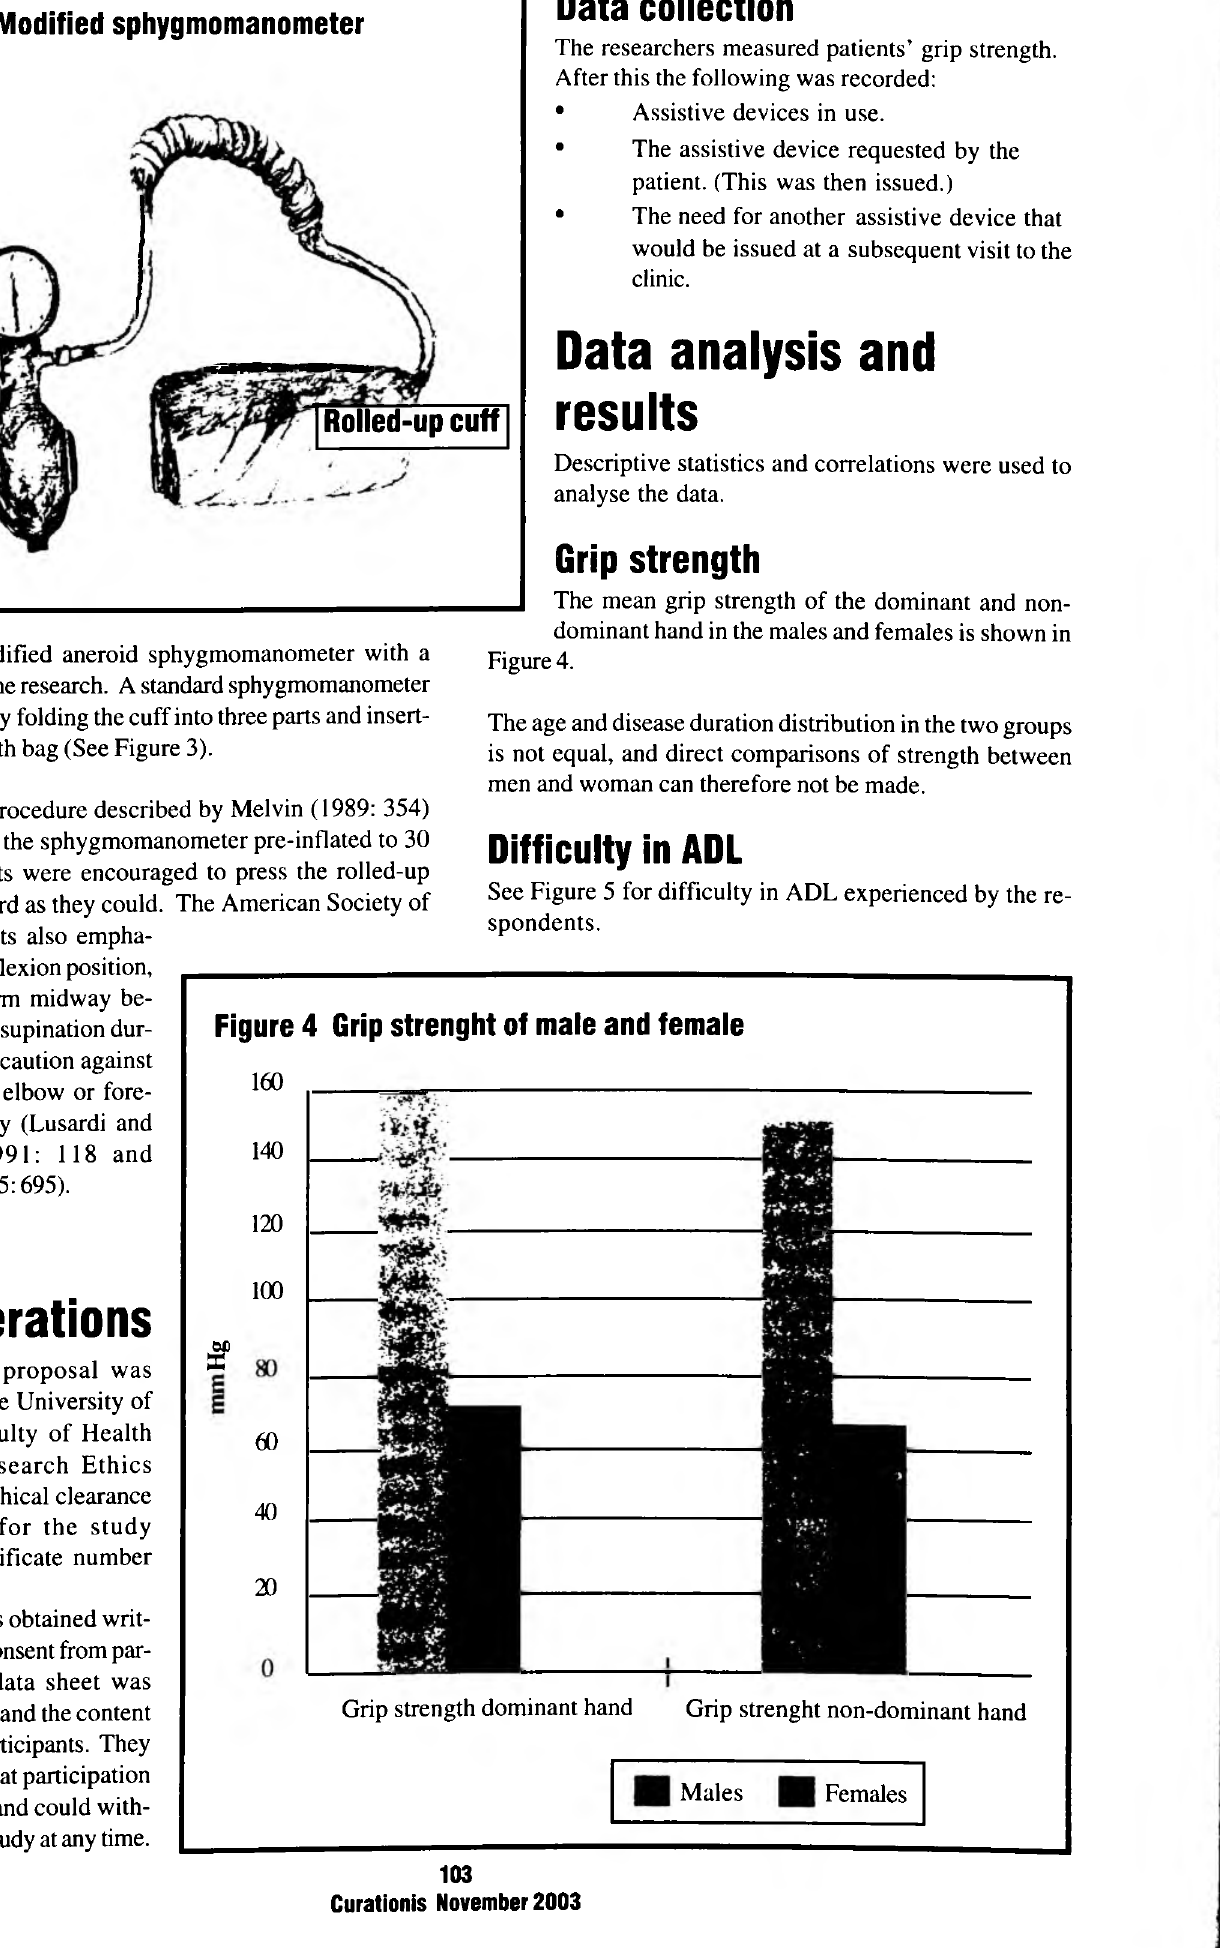
Figure 3 Modified sphygmomanometer